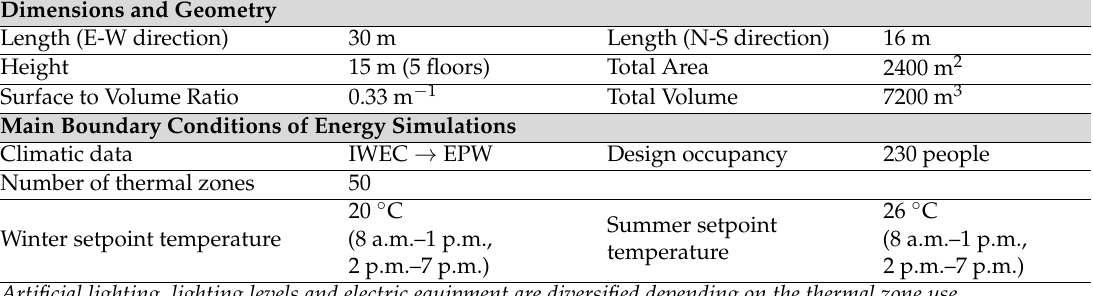
Table 5. Characterization of the